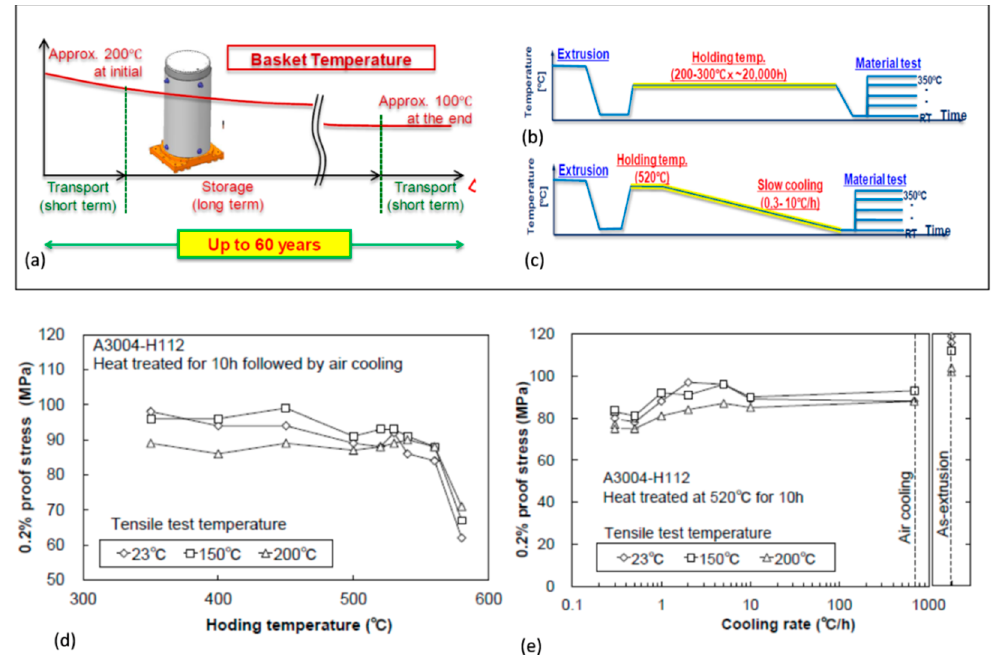
Figure 16. Evaluation of thermal stability of an aluminum alloy for long-term storage/transportation casks for spent fuel in nuclear power plants: ( a ) design requirements of temperature − time exposures; ( b ) long-term holding treatment parameters; ( c ) parameters of annealing and slow cooling treatments; ( d , e ) yield stress of the AA3004 H112 extruded alloy after treatment and testing at temperatures indicated [16,16].